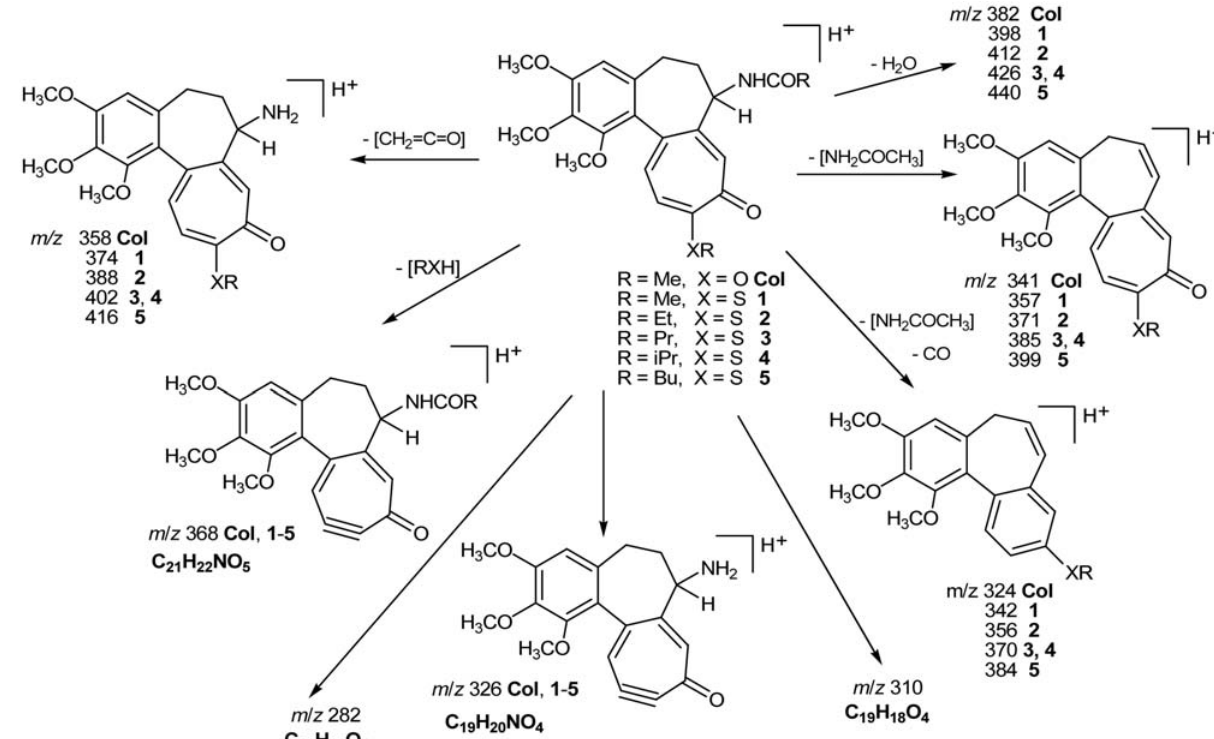
Table 3. The values of μ isomeric 3 and 4 compounds. μ